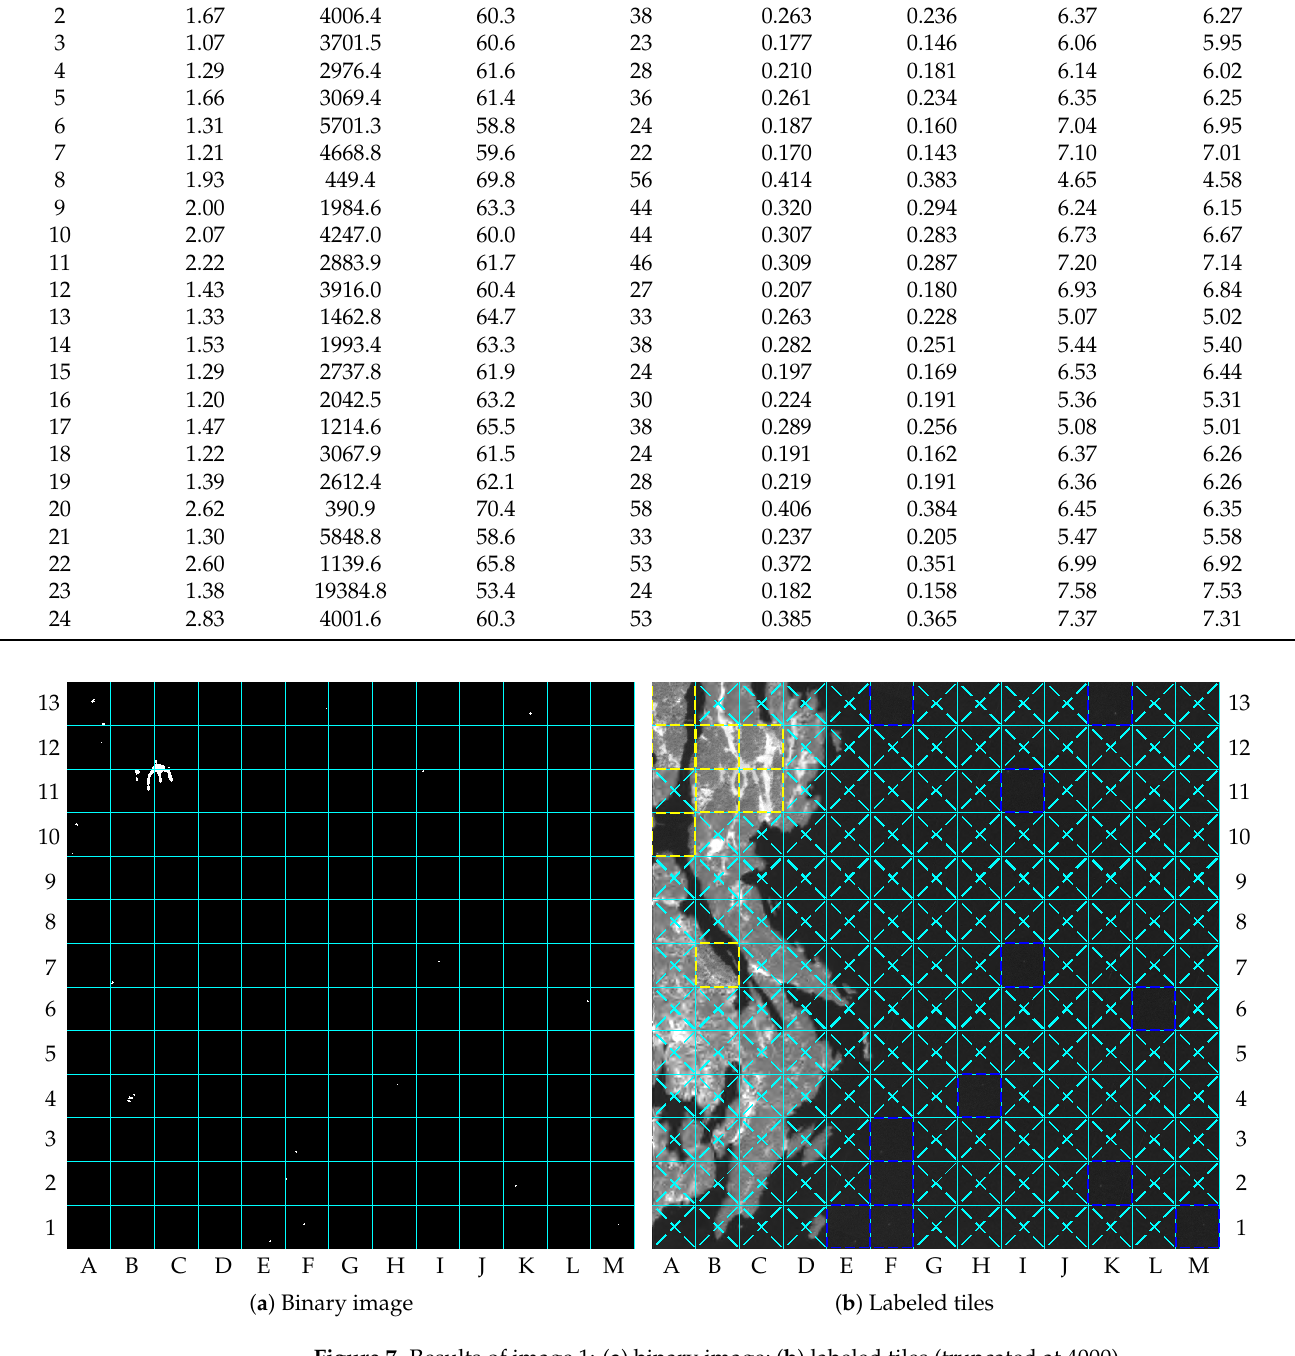
Figure 7. Results of image 1: ( a ) binary image; ( b ) labeled tiles (truncated at